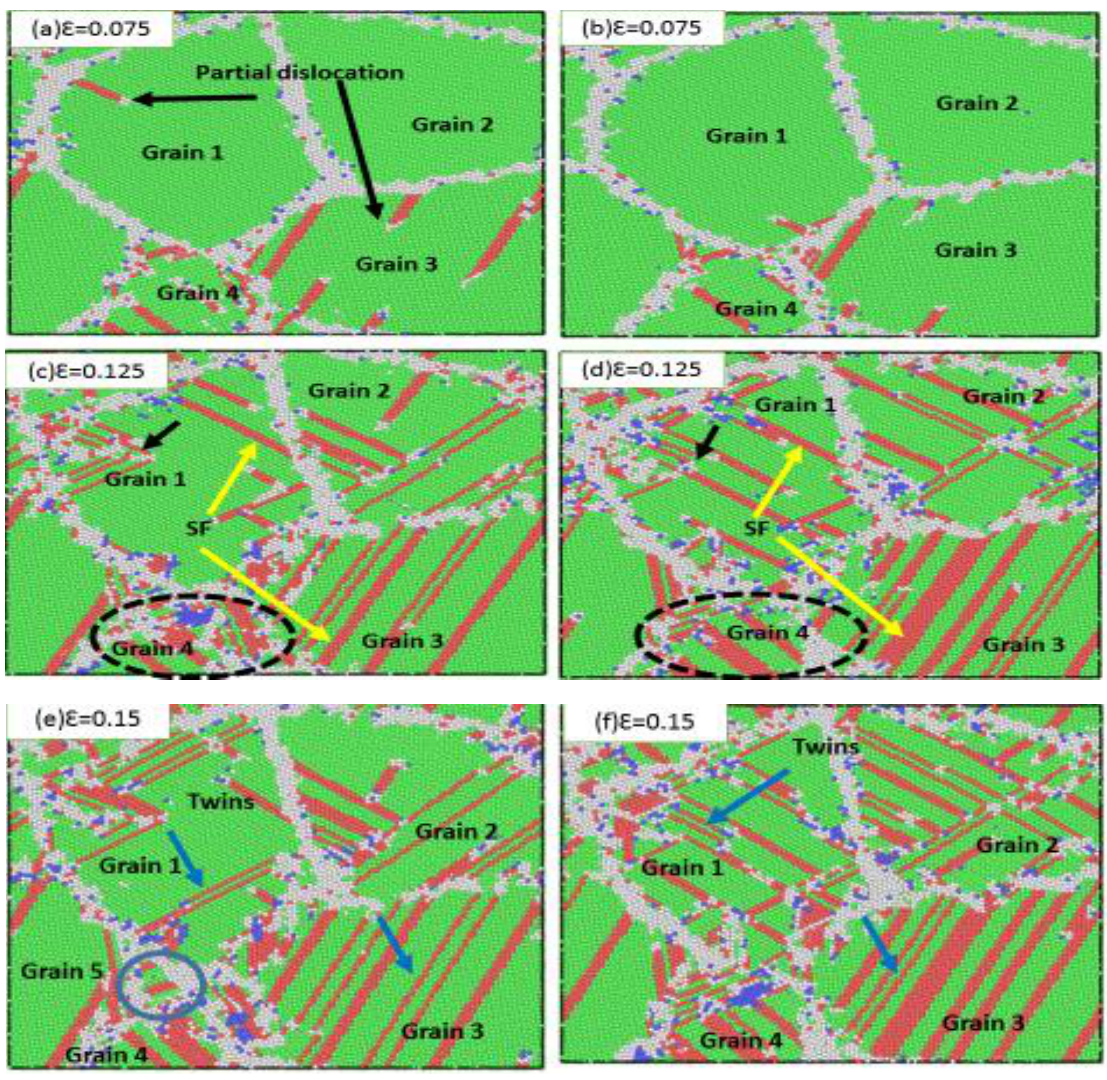
Figure 6. Snapshots of the simulated stainless-steel with a mean grain size of 9.9 nm, deformed at strain rates of ( a , c , e ) 6 × 10 9 s −1 and ( b , d , f ) 1 x 10 10 s −1 . ( a ) and ( b ) present 0.075 true strain; ( c ) and ( d ) present 0.125 true strain; ( e ) and ( f ) present 0.15 true strain. Black arrows in ( a ) and ( b ) indicate partial dislocation, yellow arrows in ( c ) and ( d ) indicate the stacking fault, and blue arrows indicate deformation twins.